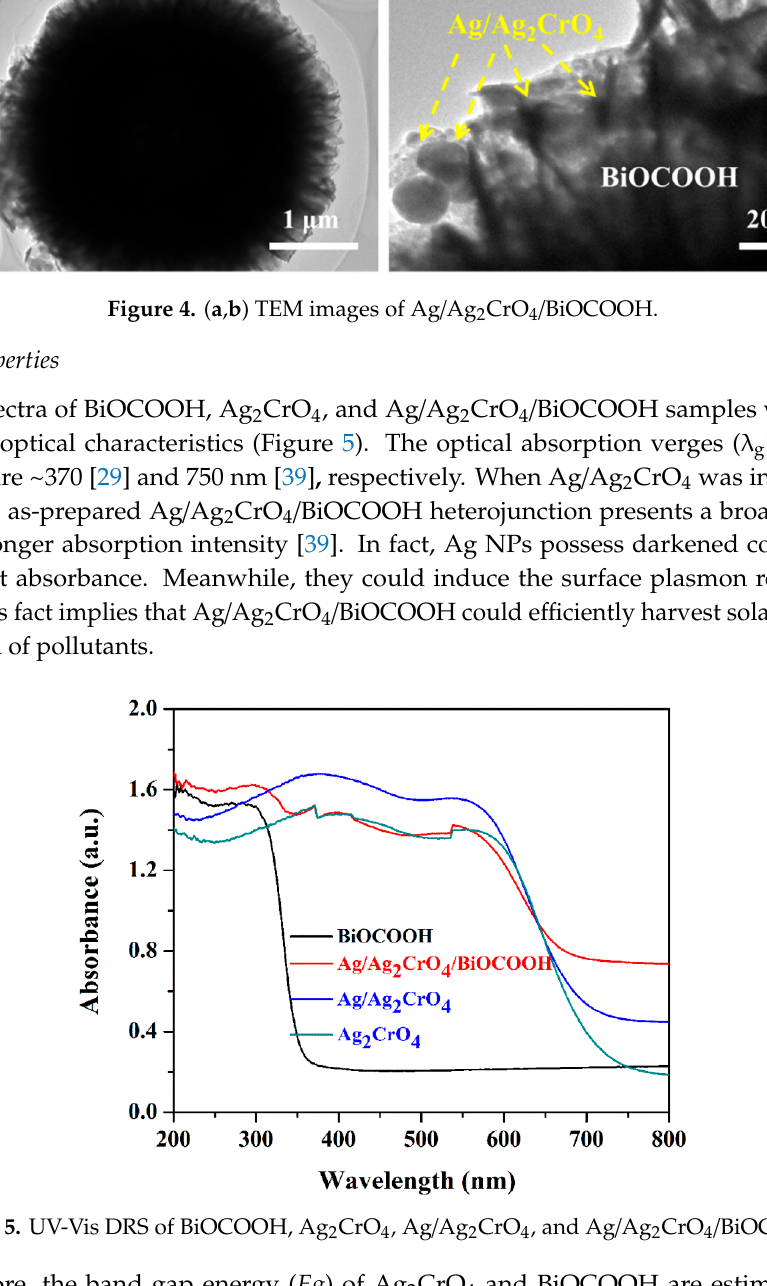
Figure 4. ( a , b ) TEM images of Ag/Ag 2 CrO 4 /BiOCOOH.